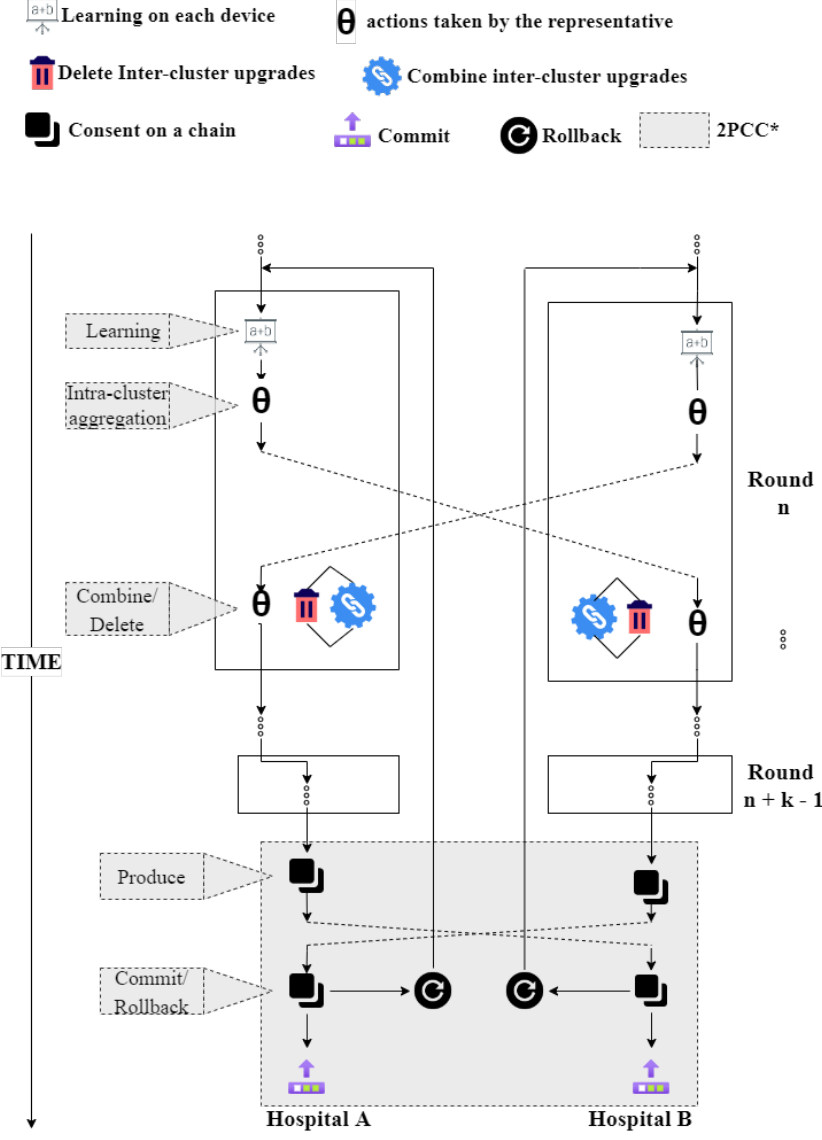
Figure 9. The DefCon algorithm’s process flow